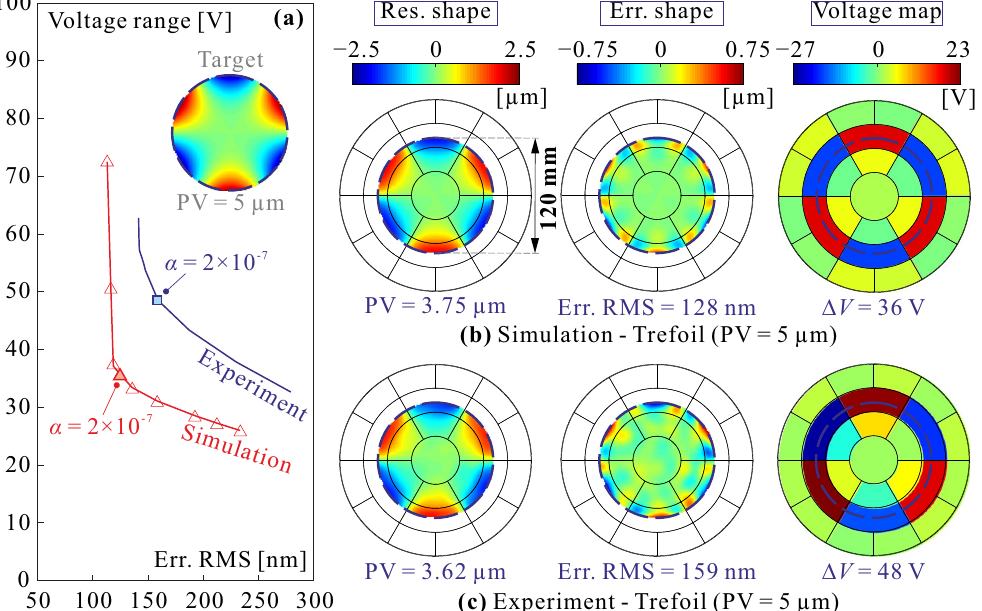
Figure 7. Trefoil mode with a Peak to Valley (PV) amplitude of 5 µ m in a pupil of 120 mm. ( a ) L-curves showing the trade-off between the voltage budget and the fitting error. ( b ) Reflector shape in the pupil, fitting error and voltage map using the numerical influence functions and α = 2 × 10 − 7 . ( c ) Same with the experimental influence